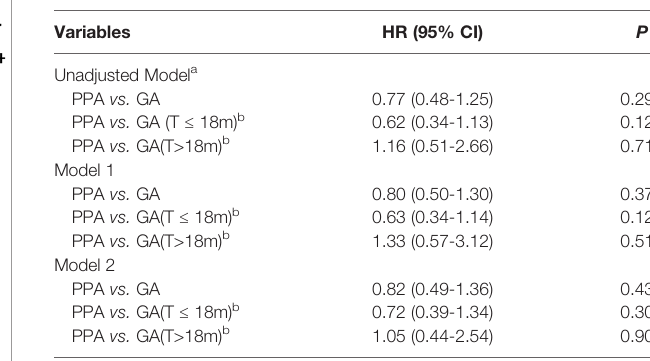
TABLE 2 | Extended Cox regression model with estimated recurrence hazard ratios of PPA vs. GA in ER-negative